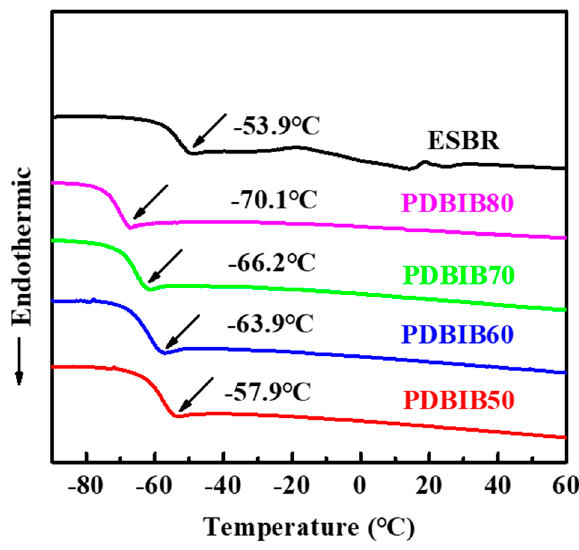
Figure 3. DSC thermograms of the synthesized PDBIB and ESBR.